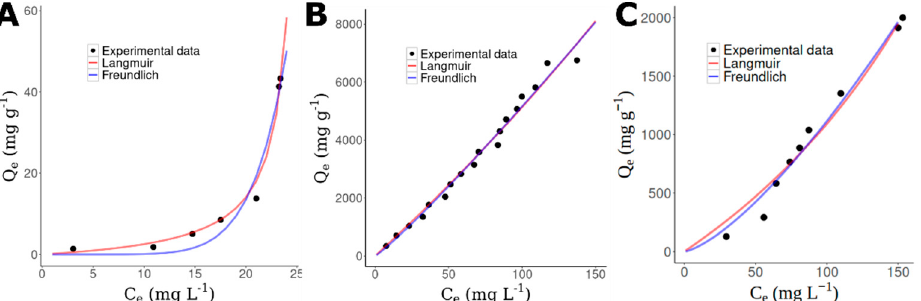
Figure 5. Adsorption isotherms of the ( A ) NQ@SBA − 15, ( B ) 2NQ@SBA − 15, and ( C ) 5NQ@SBA − 15 systems fitted to Langmuir (red) and Freundlich (blue) models.